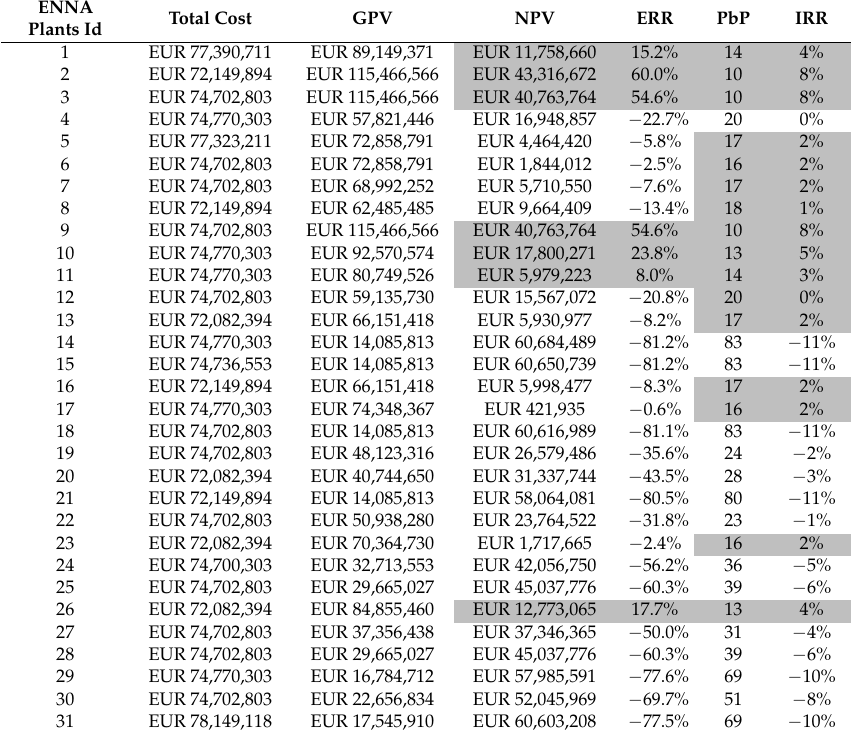
Table 3. Results of the DCFA applied to the wind farm investments (31 plants in the province of Enna): GPV—Gross Present Value; NPV—Net Present Value; ERR—External Rate of Return; PBP—Pay Back Period; IRR—Internal Rate of Return (our